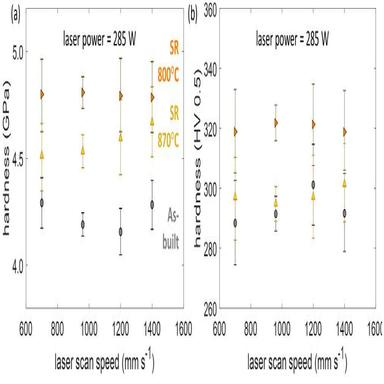
(a) nanoindentation hardness versus laser scan speed and (b) microindentation versus laser scan speed for a fixed laser power of 285 W. See for a description of the interval calculations.